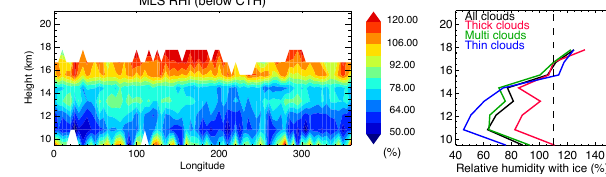
Fig. 7. Relative humidity with respect to ice below cloud top from MLS.